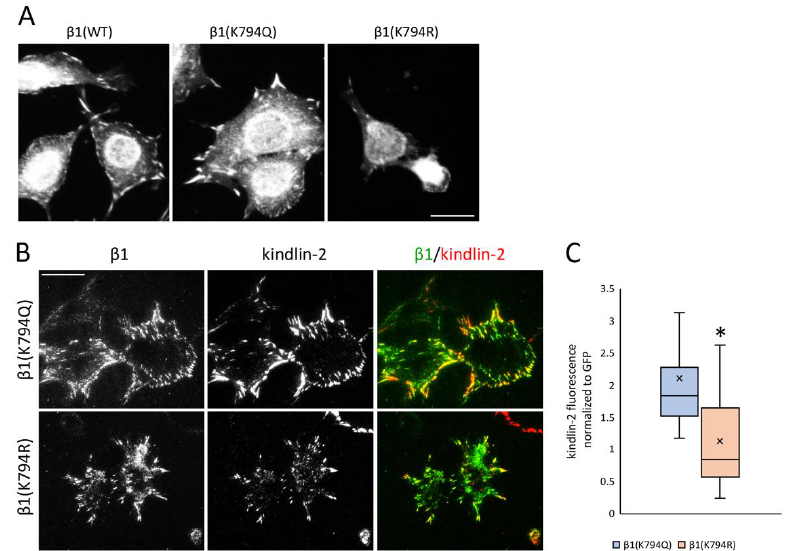
Figure 5. Kindlin-2 recruitment to β1 integrin focal adhesions. ( A ) Individual GD25 cells are shown. Cells were allowed to spread on a FN-coated surface for 4 h followed by fixing and staining with anti-kindlin-2 antibodies and visualization by epifluorescence. Scale bar = 10 μm. Fields of kindlin-2 stained cells are shown in Figure S4. ( B ) TIRF microscopy was used to visualize immunostained kindlin-2 and GFP-tagged β1 integrin in β1(K794Q) and β1(K794R) cells on a FN-coated surface. Scale bar = 10 μm. ( C ) Average fluorescence intensities of kindlin-2 normalized to GFP for n = 30 cells per condition. Box-plot crossline is the median and x indicates the mean. * p < 0.001.